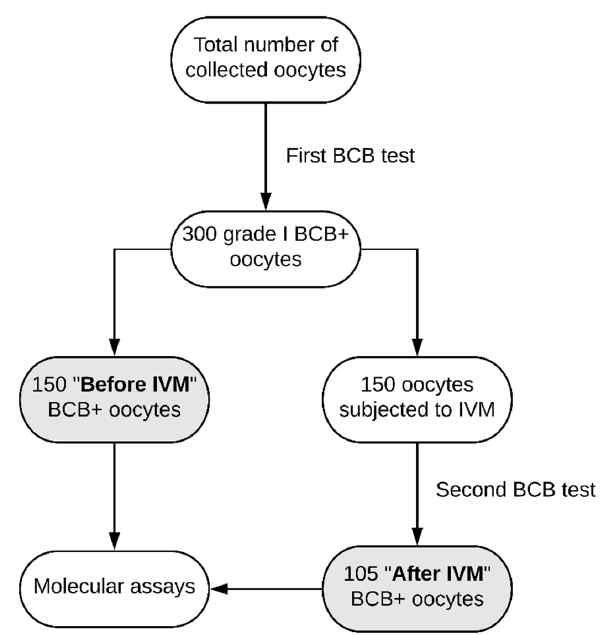
Figure 9. Experimental design, presenting procedures and numbers of oocytes in each stage of selection, applied to every biological replicate.